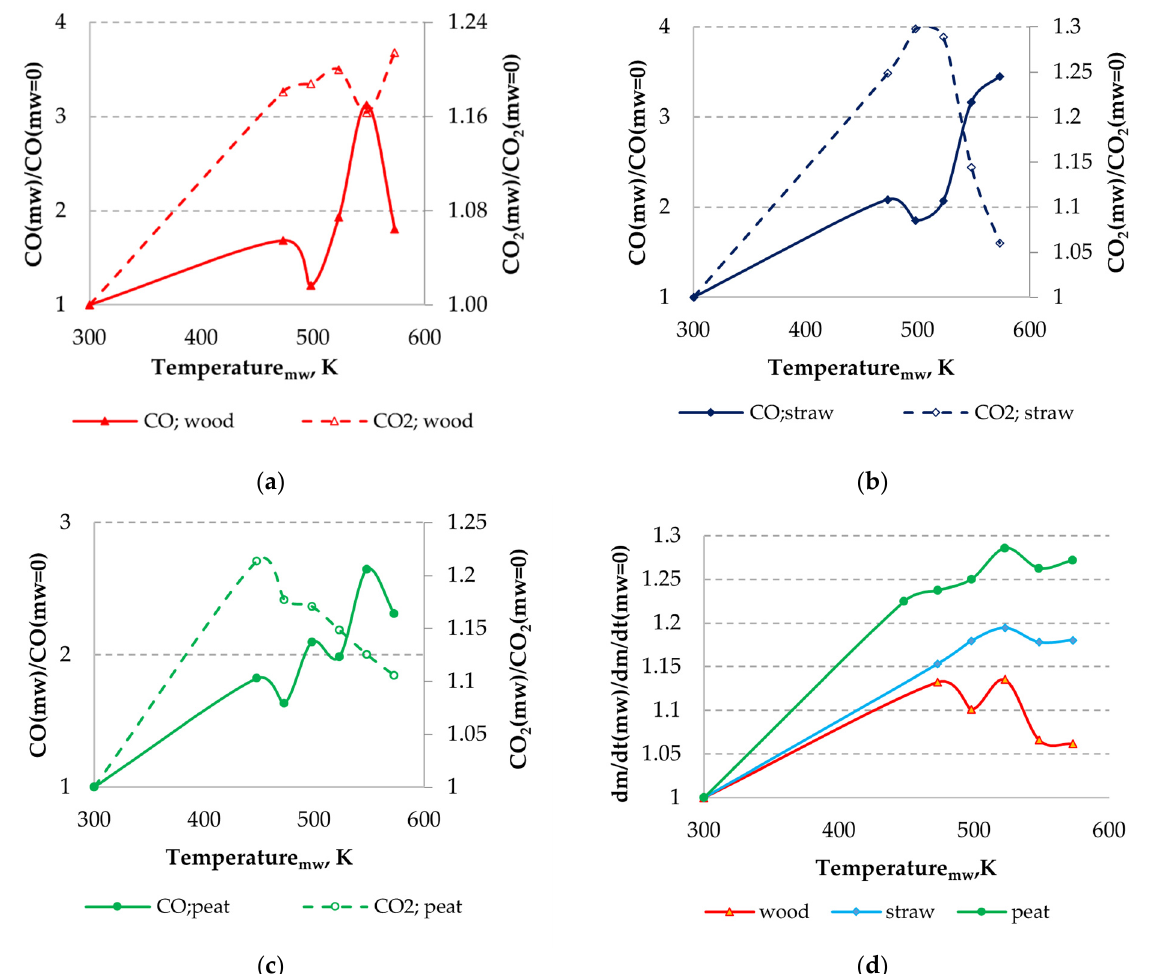
Figure 7. Effect of increasing the pretreatment temperature on the average values of the yield of volatiles: CO, CO 2 during the thermal decomposition of pretreated wood ( a ), wheat straw ( b ) and peat pellets ( c ) and on the relative variations of the weight loss rate of pretreated pellets ( d ).